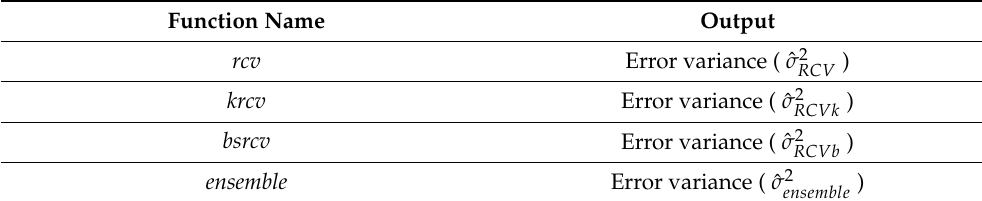
Table 1. Available functions in package